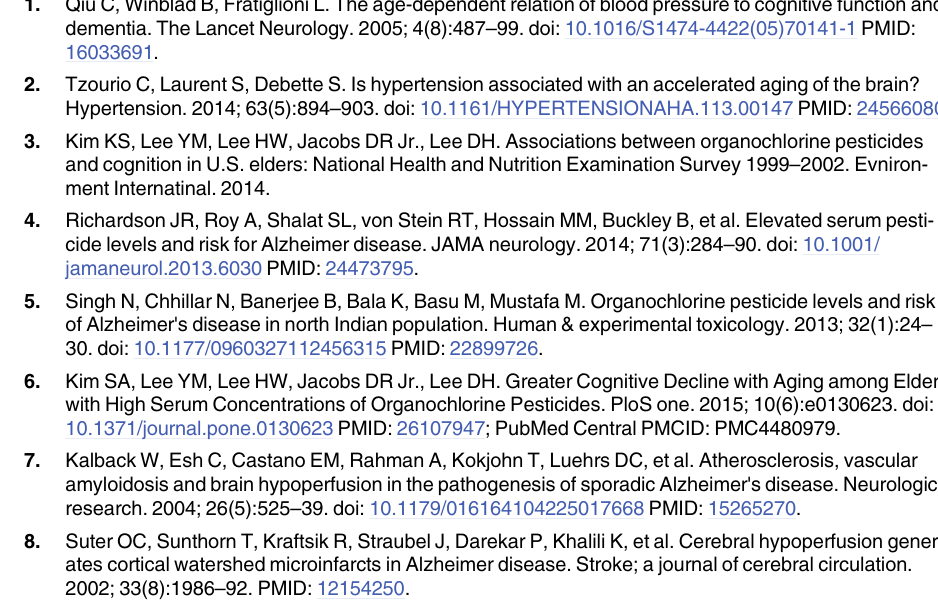
S1 Table. Adjusted (cid:3) means of Digit Symbol Substitution Test score among all subjects or stratified by tertiles of serum concentrations of organochlorine pesticides. S2 Table. Adjusted (cid:3) odds ratios (ORs) and 95% confidence intervals (CIs) between hyper- tension and the risk of low Digit Symbol Substitution Test score ( < 25 th% of study subjects) among all subjects or stratified by serum concentrations of organochlorine (OC)